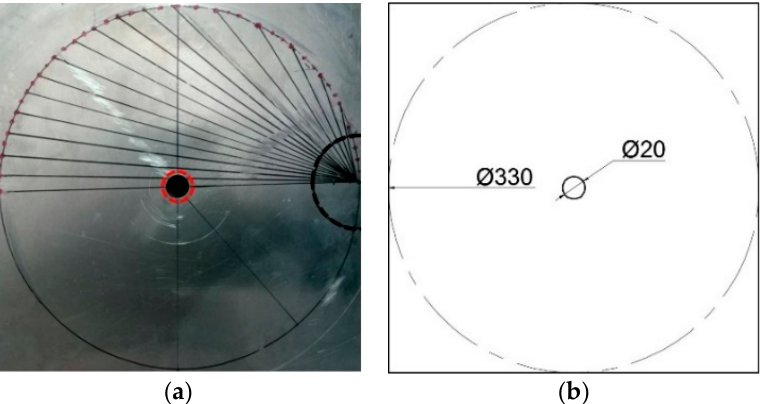
Figure 23. Circular defect specimen #1: ( a ) Circular defect specimen; ( b ) Circular defect specimen drawing (Unit: mm).